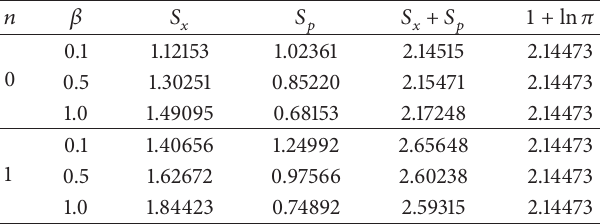
Table 1: The numerical results that establish the BBM entropic uncertainty relation for 𝑚 = ℏ = 𝜔 = 1 and various values of 𝛽